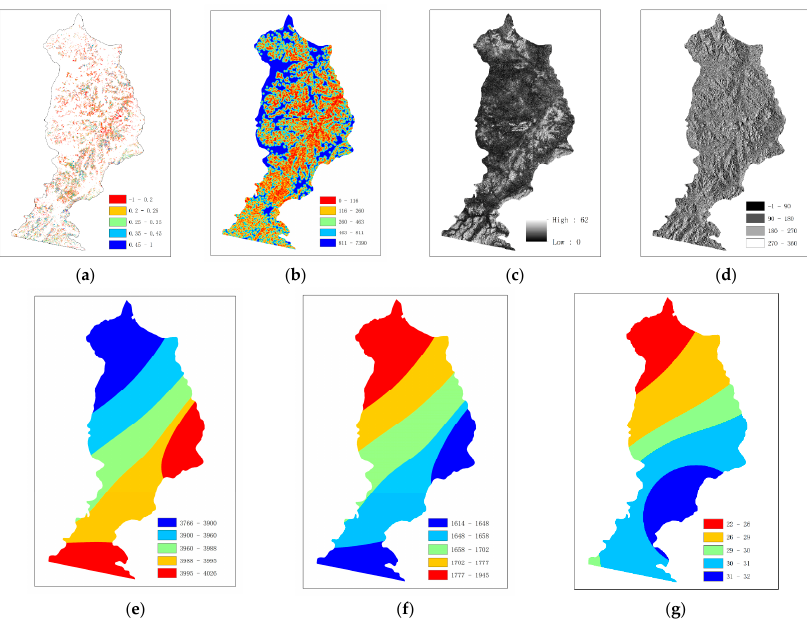
Figure 11. The raster maps of seven variables in the prediction process for the year 2012. ( a ) NDII5 of year 2011; ( b ) Distance with the pine forests severely damaged in the 2011, unit was meter; ( c ) Slope, unit was degree; ( d ) Aspect, unit was degree; ( e ) Average active accumulated temperature of years 2008–2012 (Last August–July, >6 °C), unit was °C; ( f ) Average Sunshine Duration of years 2008–2012 (Last August–Last October and April–July), unit was hour; ( g ) Average October Rainfall of years 2008–2012, unit was.